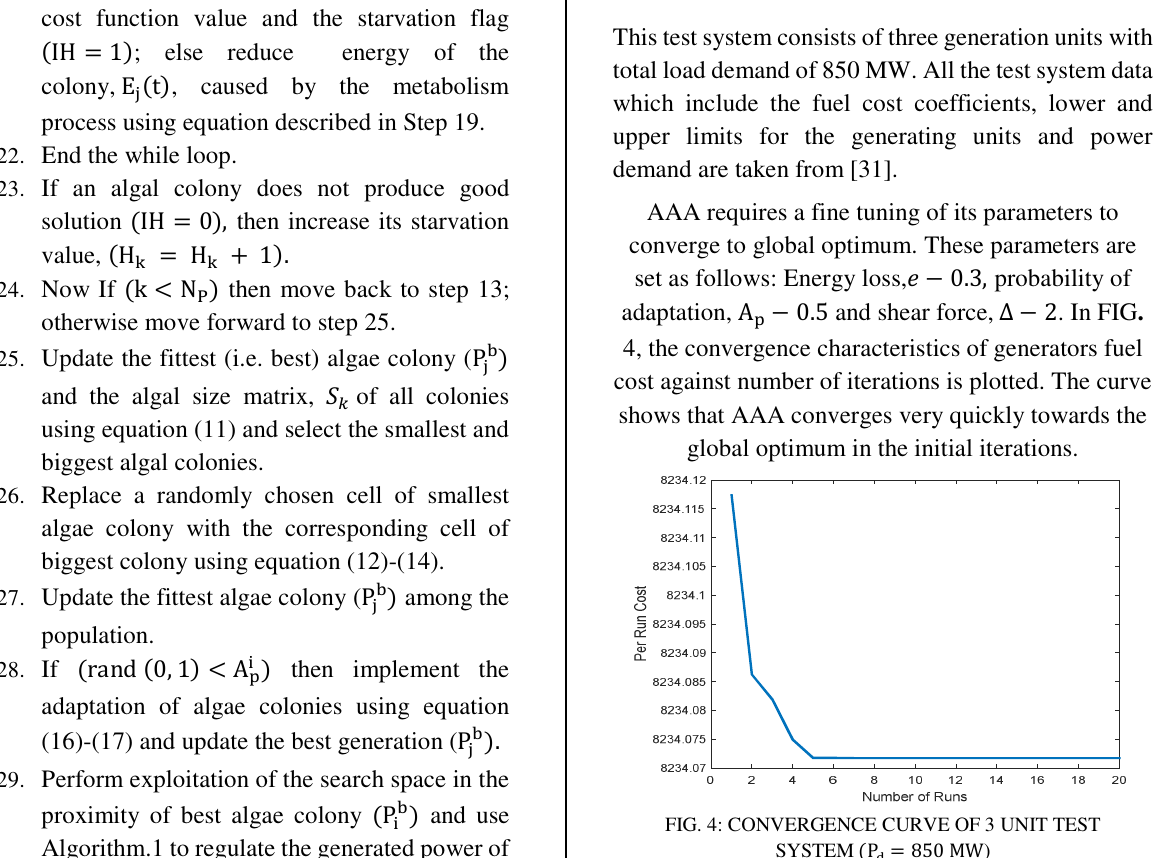
Algorithm.1 to regulate the generated power of